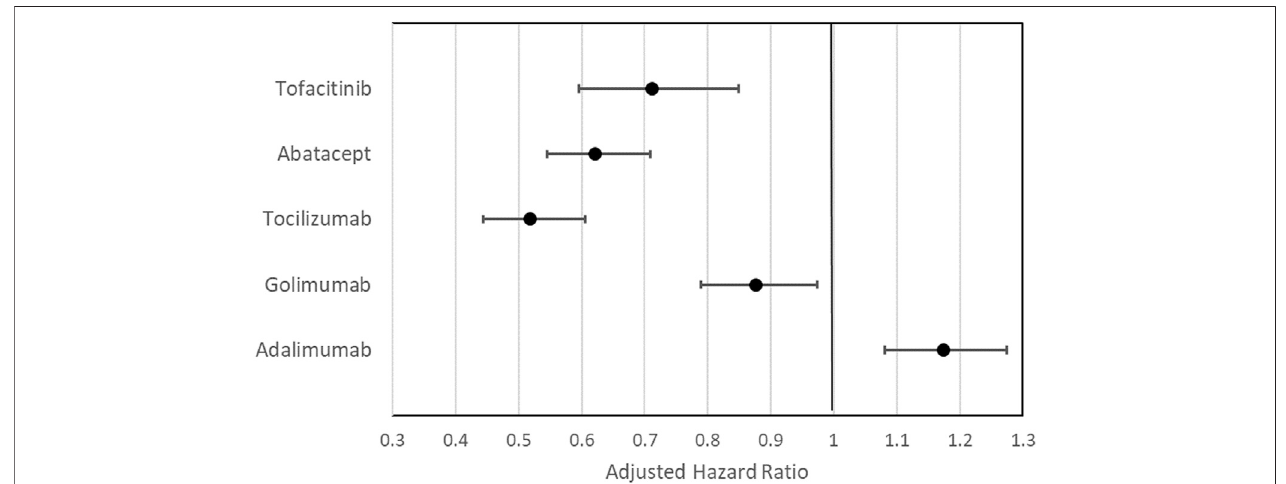
FIGURE 4 | Adjusted hazard ratio (aHR) with 95% con fi dence interval of the effects of index treatment on the cumulative probability of switching/discontinuation in the Cox proportional regression analysis with etanercept set as the reference group. a Adjusted for age at index, gender; CCI, comorbidities; use of MTX, use of other csDMARDs other than MTX, and use of steroid.